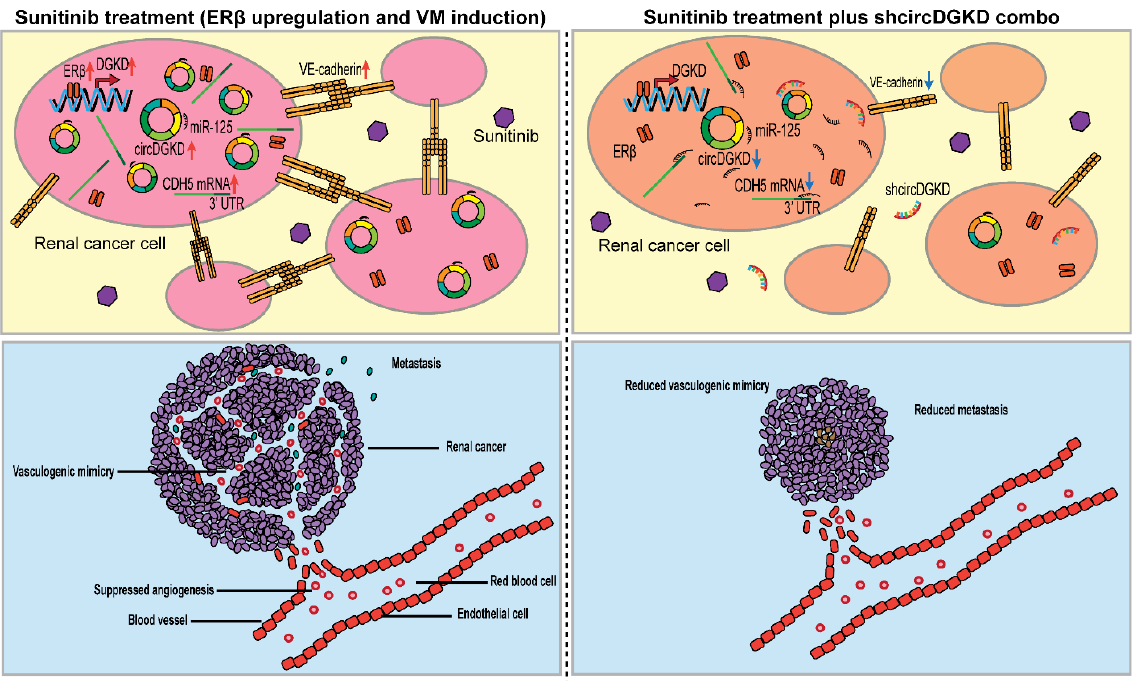
Figure 7. Mechanism diagram illustrating that sunitinib induces VM formation by up-regulating ER β /circDGKD/miR-125-5p/VE-cadherin axis, whereas sunitinib plus shcircDKGD combo treatment suppresses angiogenesis and VM simultaneously. Red arrows stand for increase and blue arrows stand for decrease.